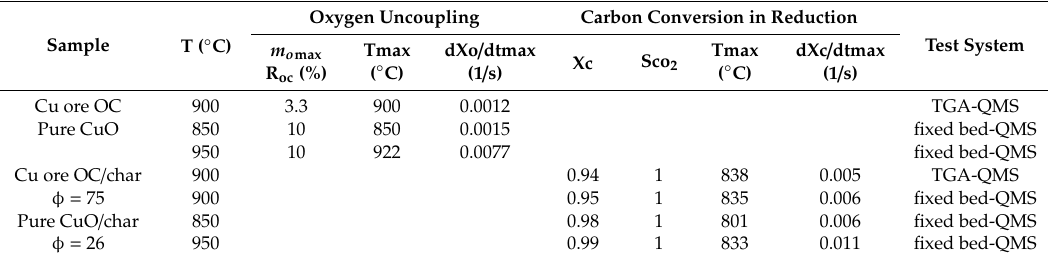
Table 3. Oxygen capacity, carbon conversion e ffi ciency, maximum conversion, and conversion rates and temperatures for Cu ore OC in Ar at 900 ◦ C and pure CuO from reference